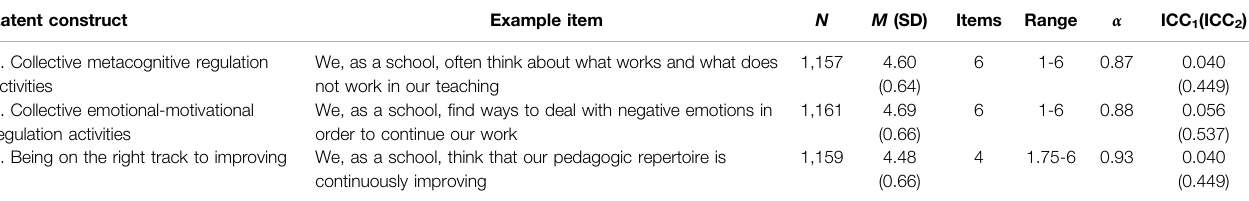
TABLE 3 | Measurement instruments to assess collective regulation activities and feeling of the school being on the right track, with example item and scale